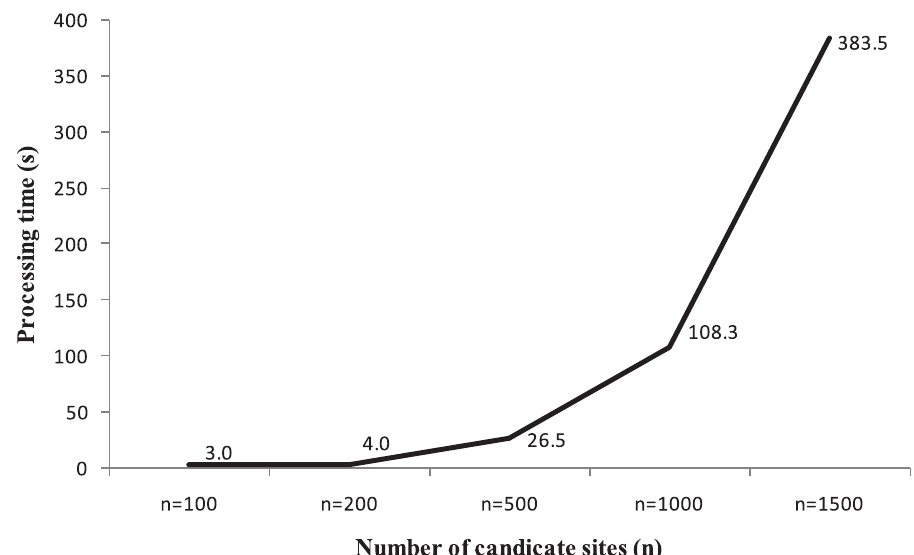
Figure 1. Relationship between processing time and the number of candidate sites (Williams (2002) model was used. population coefficient α =2.0. See text for detailed explanation of α